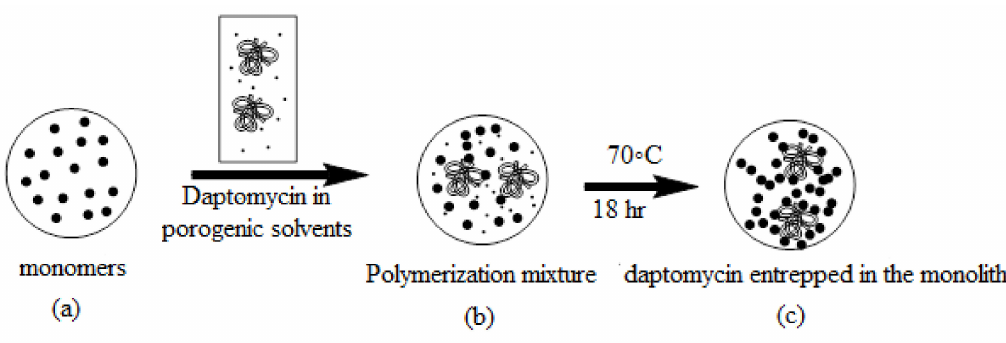
Figure 9. Schematic diagram showing the encapsulation technique of